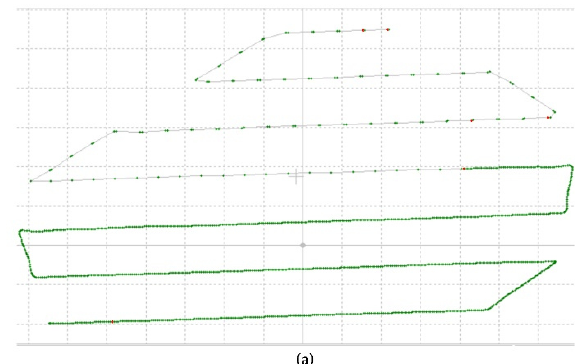
processing. A partially successful computation. Green dots represented fixed GPS/GNSS solutions while red dots are float